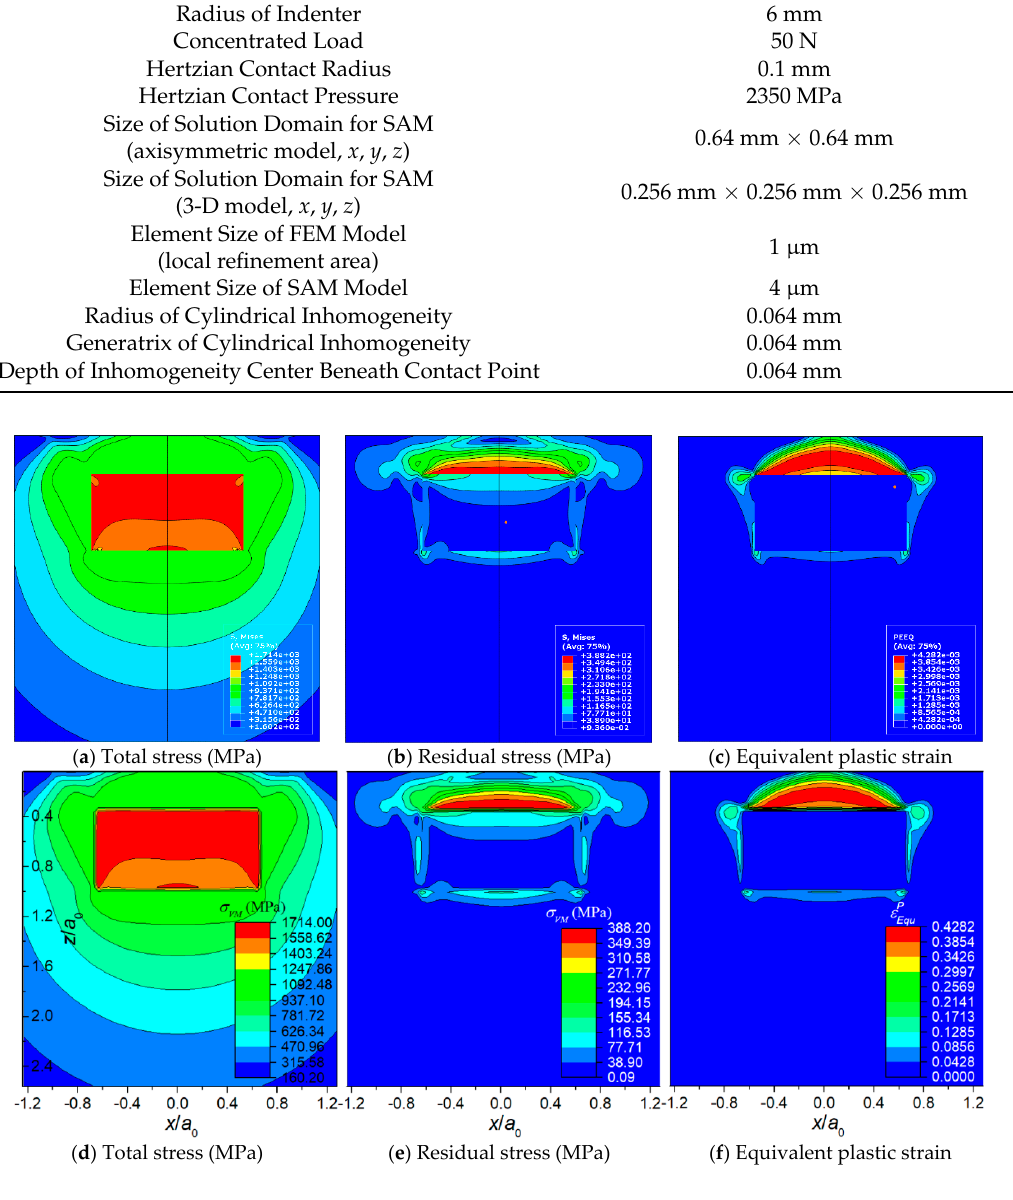
Figure 8. Case 1: The inhomogeneity is stiff and elastic and the matrix material is elasto-plastic. ( a – c ) results of FEM, ( d – f ) results of SAM.